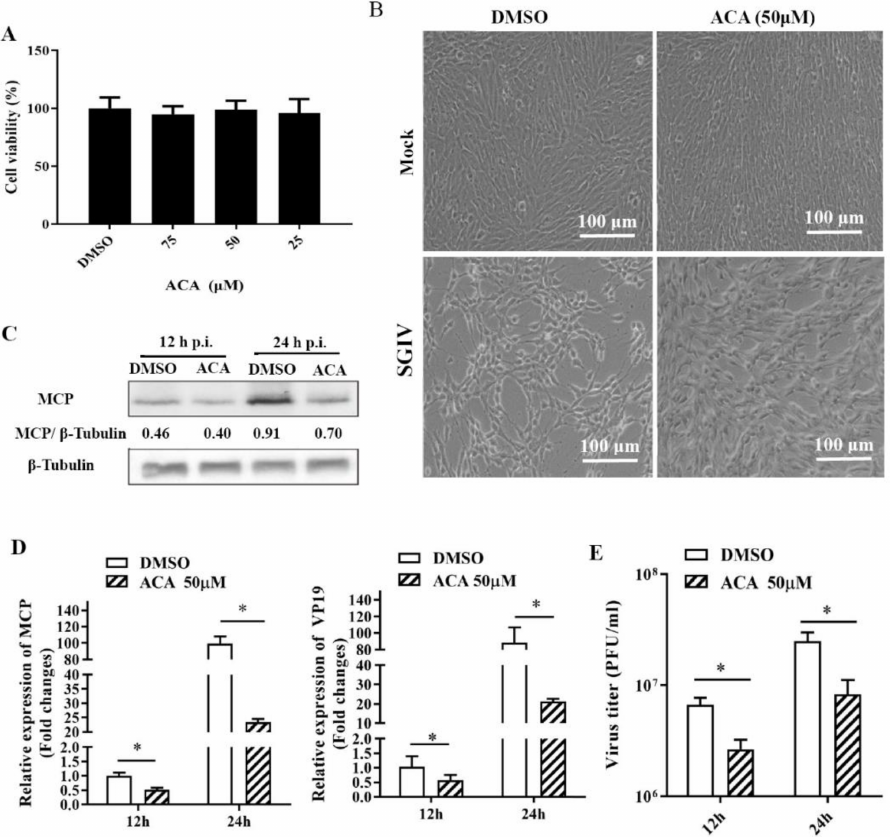
Figure 3. SGIV replication was inhibited by a broad-spectrum PLA2 inhibitor, Anthranilic acid (ACA), in vitro. ( A ) The cytotoxicity of ACA on GS cells was determined using MTT assay. ( B ) The severity of CPE induced by SGIV infection at 24 h p.i. in ACA-treated cells. ( C ) Western blotting analysis of viral major capsid protein (MCP) during SGIV infection in ACA-treated cells. ( D ) The effect of ACA on viral gene transcription during SGIV infection. ( E ) The effect of ACA on virus titers during SGIV infection. The asterisks (*) indicated p <